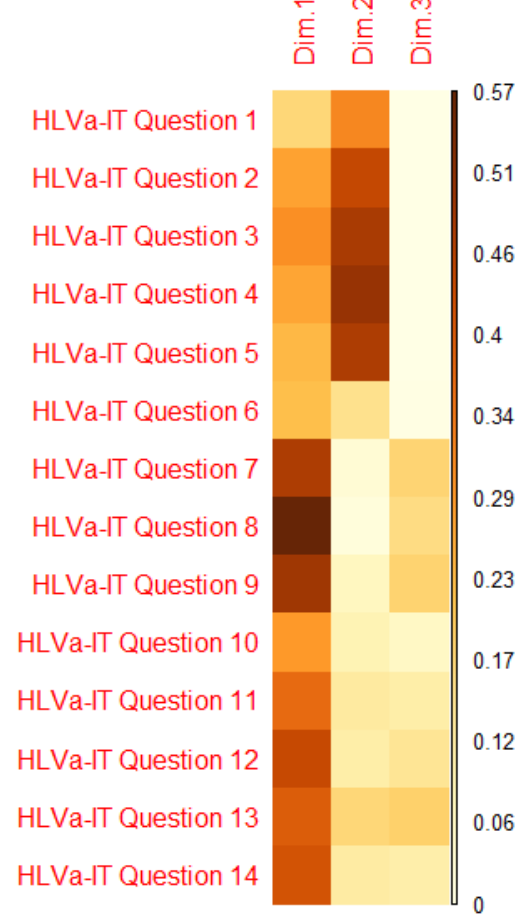
Figure 2. Quality of representation of variables on the factor map.